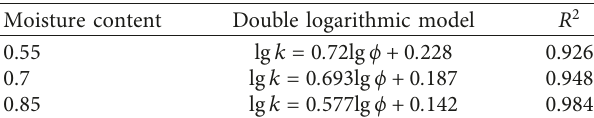
Table 4: Parameters for the fitting formula of permeability and porosity. Moisture